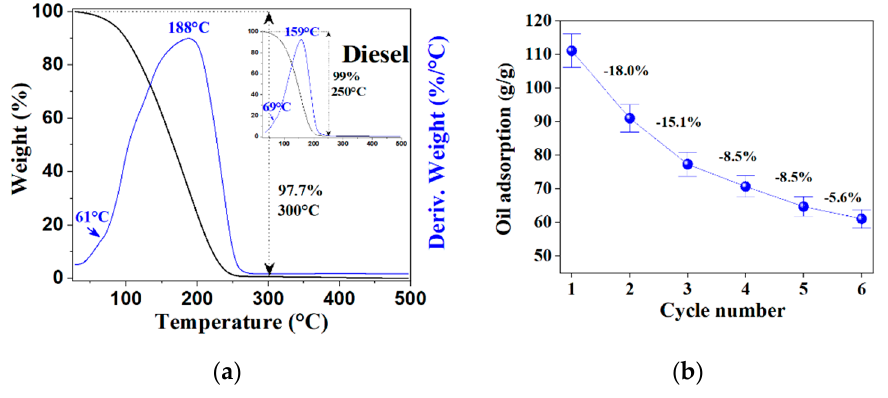
Figure 11. Thermograms with weight change and its derivate of saturated EG 0-2 sample and